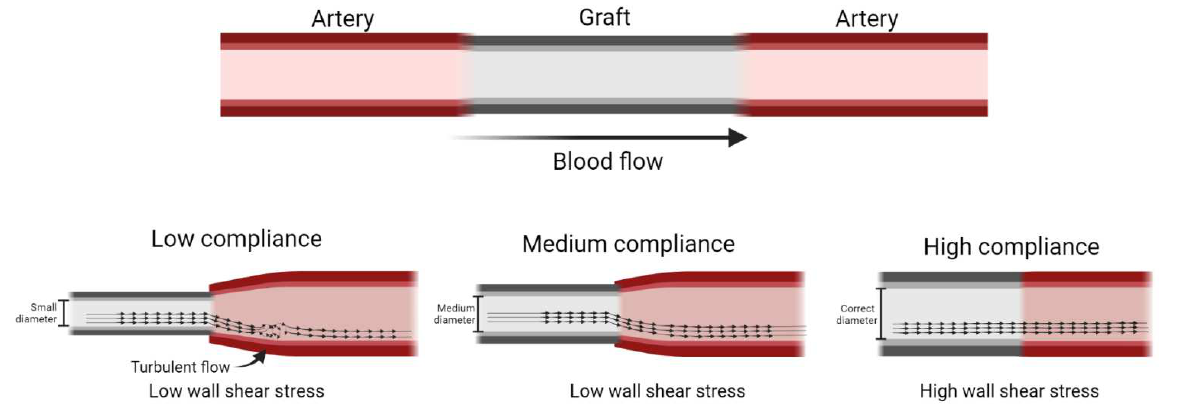
Figure 5. Effect of compliance on flow patterns and wall shear stress at the distal anastomosis in a VGs. Data retrieved from Post A, et al. [45] Image created with BioRender.com (accessed on 29 May 2022).